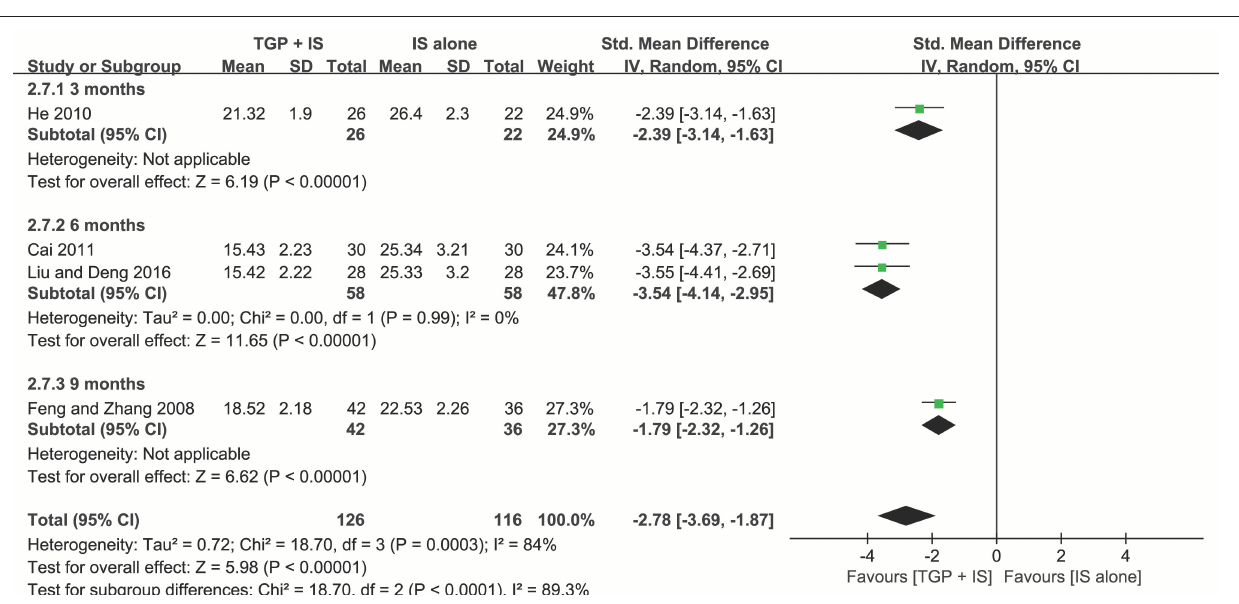
FIGURE 7 | Subgroup analysis of serum γ -globulin based on intervention duration of TGP + IS vs. IS